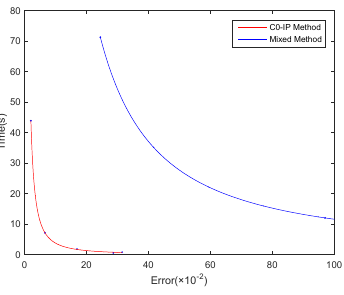
Figure 2. Computational time for C 0 -IP method and mixed method for Experiment 1.